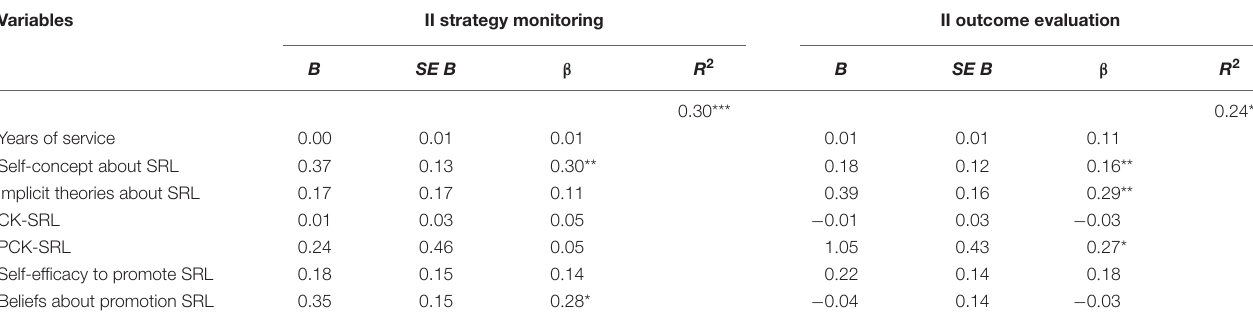
TABLE 5 | Regression analyses for the intention to implement specific aspects of SRL in class